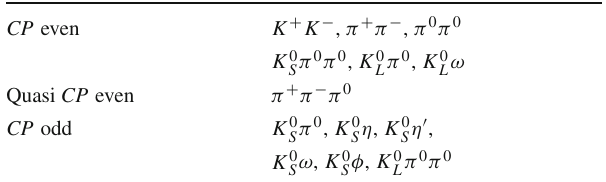
Table 2 Summary of CP -eigenstate tag modes used in the determina- tion of A K π and A πππ 0 K